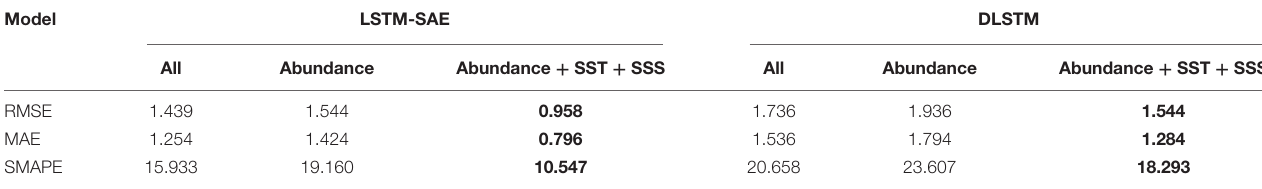
TABLE 4 | Prediction performance